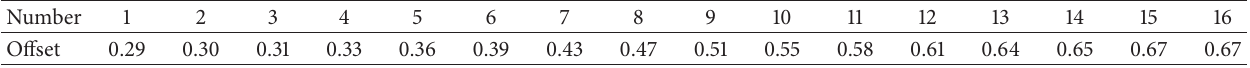
Table 1: Offset value of the subarray slots (16 slot-microstrip elements) from the waveguide centreline, unit in millimeter.